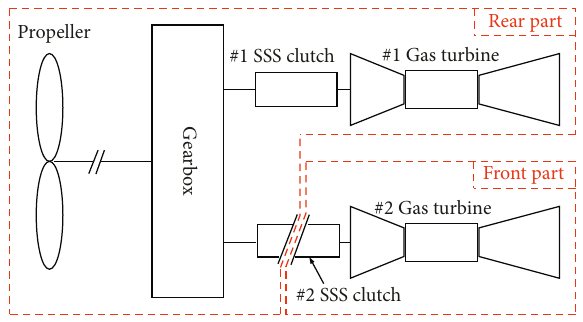
Figure 3: The forces acting on the driving unit. Figure 2: The division of a COGAG